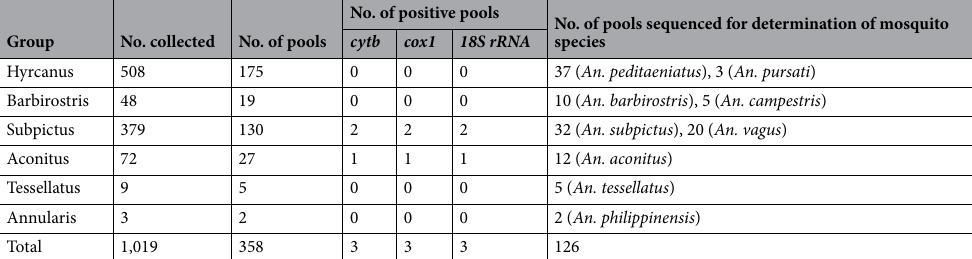
three pools (0.84%) out of 358 pools were positive for P. caprae . These mosquito samples were the Aconitus group (ID THMosGoat21-02_P11) and the Subpictus group (IDs THMosGoat21-01_P18 and THMosGoat21-01_P38) (Table 1). It should be noted that three mosquito pools that were PCR positive to P. caprae consisted of two pools of unfed mosquitoes (one pool each of An. subpictus and An. aconitus ) and one pool of blood-fed mosquitoes ( An. subpictus ). Minimum infection rates (MIR) were 1.4% (95% CI 0.25–7.46) in the Aconitus group mosquito and 0.9% (0.25–3.24) in the Subpictus group mosquito (Table 2). From 133 non-anopheline mosquito samples, 8 pools of 25 Culex spp. samples and 3 pools from 4 Mansonia spp. samples were subjected to PCR examination, as described above. However, none were positive for Plasmo- dium spp.